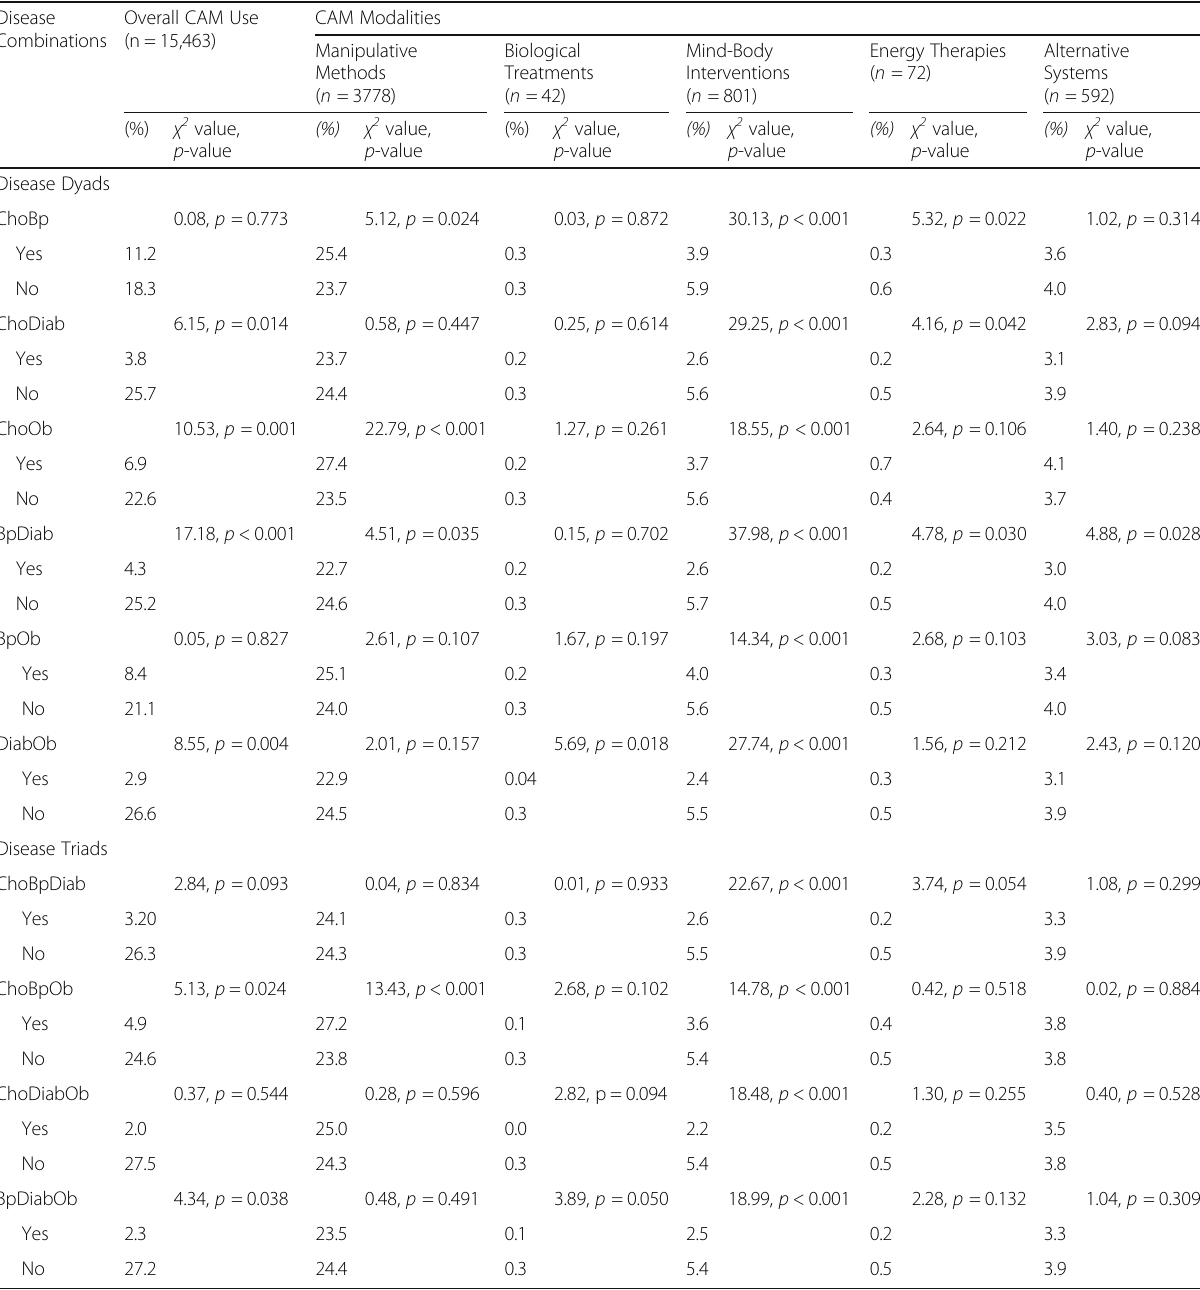
Table 3 Utilization of CAM modalities by chronic disease dyads and triads Disease Overall CAM Use Combinations (n =